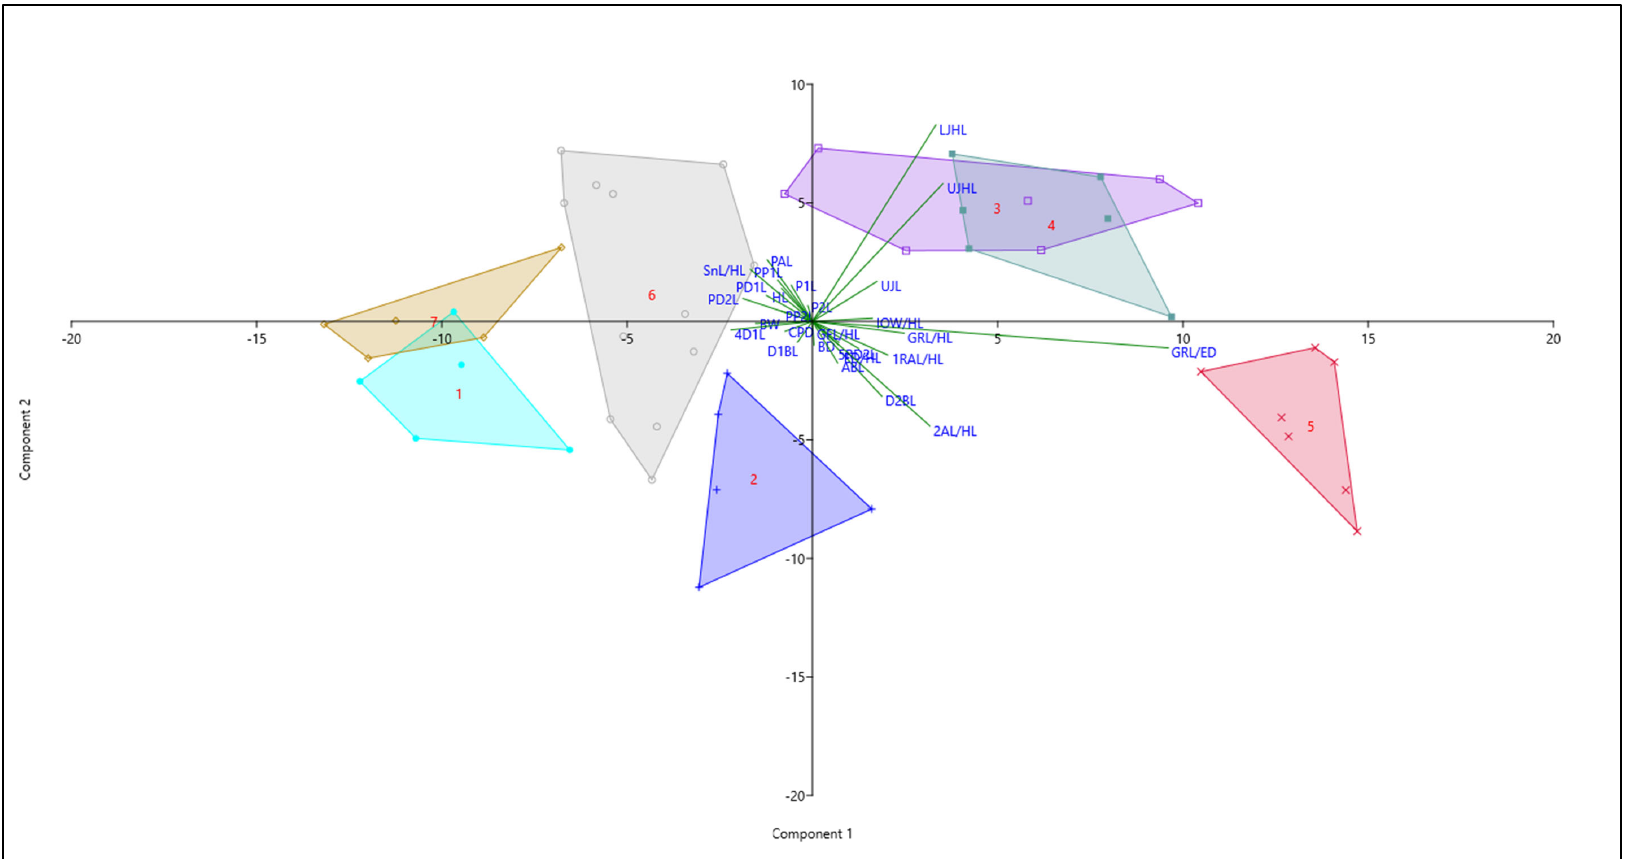
Figure 3. Scatterplots with 95% confidence interval polygons of the sheared first principal component (PC1) and sheared second principal component (PC2) of morphometric data for Johnius species from Taiwan. J. amblycephalus (1, dot), J. belangerii (2, plus), J. borneensis (3, hollow square), J. distinctus (4, filled square), J. grypotus (5, cross), J. taiwanensis (6, circle), J. trewavasae (7, diamond).